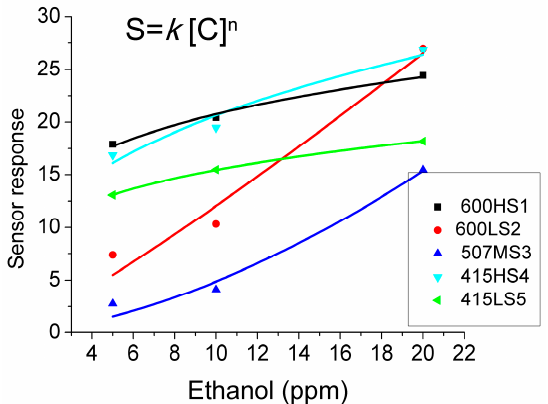
Figure 6. Calibration curves for ethanol and power law curves fitting for the different ZnO thin film sensors operated at 200 °C.